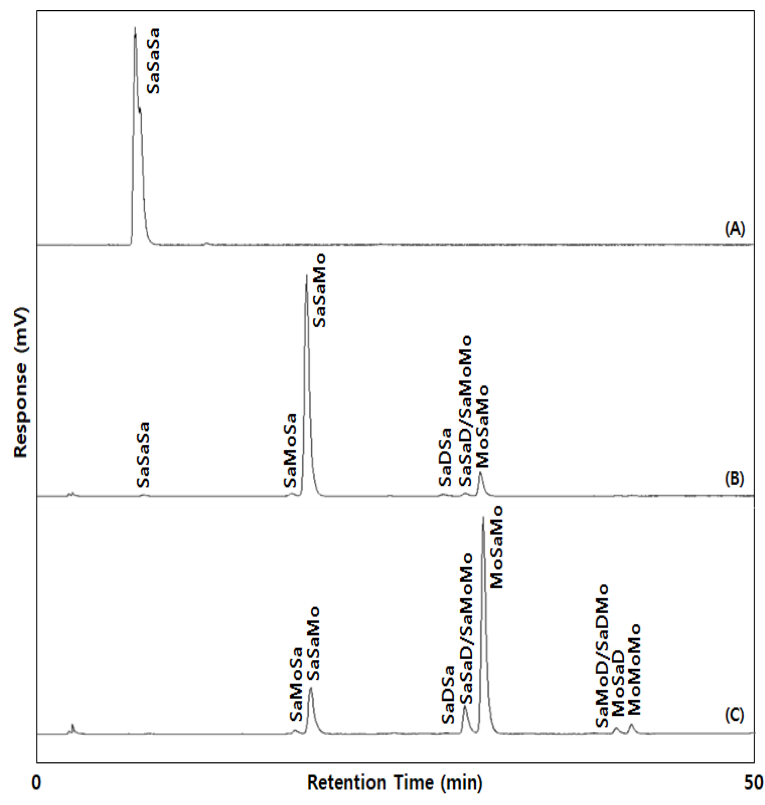
Figure 1. The Ag-HPLC chromatograms of SSS-rich ( A ), SSO-rich ( B ), and OSO-rich ( C ) fats. SaSaSa